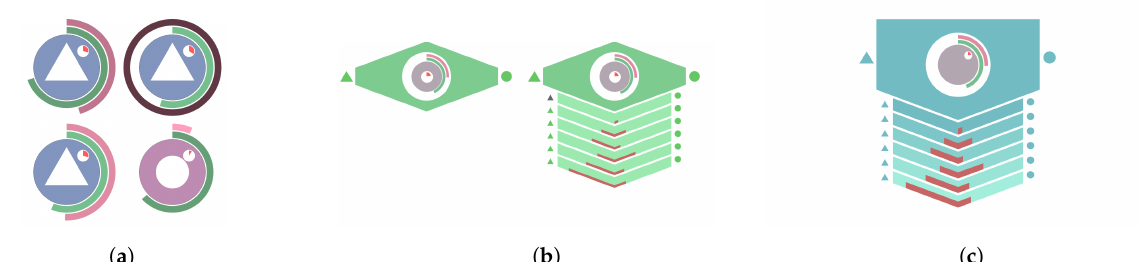
Figure 3. Some icons and abstraction levels used in NeuroScheme. ( a ) Neuron entity; ( b ) microcolumn entity; ( c ) col- umn entity.